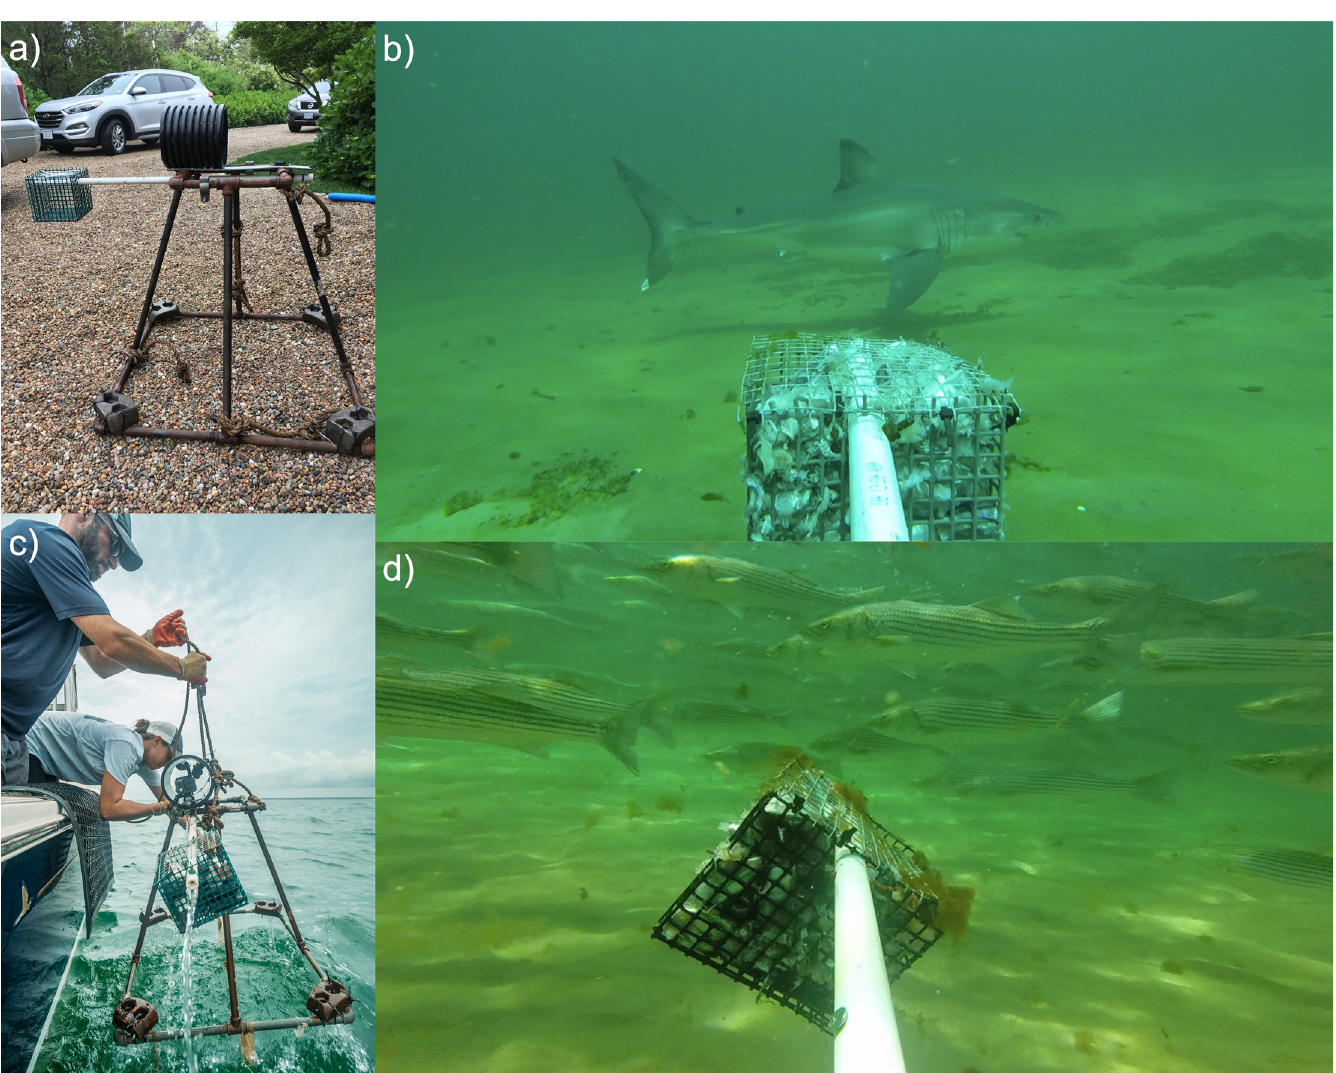
Fig 2. BRUV design and image captures. (a) BRUV assembly on dry land; (b) Still image from BRUV deployment with an opportunistically recorded white shark ( Carchardon carcharias ) in frame; (c) BRUV assembly, attached to marker buoy and with camera in place. Photo taken during BRUV retrieval; (d) Still image from BRUV deployment with a school of striped bass ( Morone saxatilis ) in